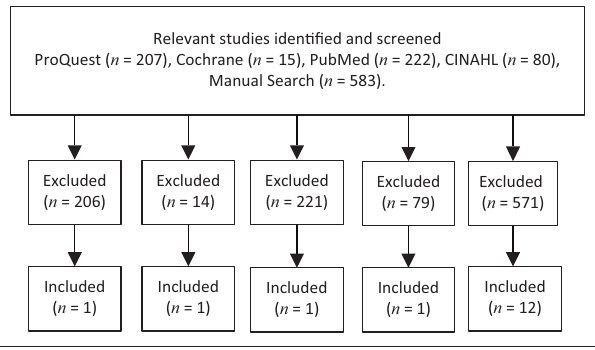
FIGURE 1: A flow chart describing the search